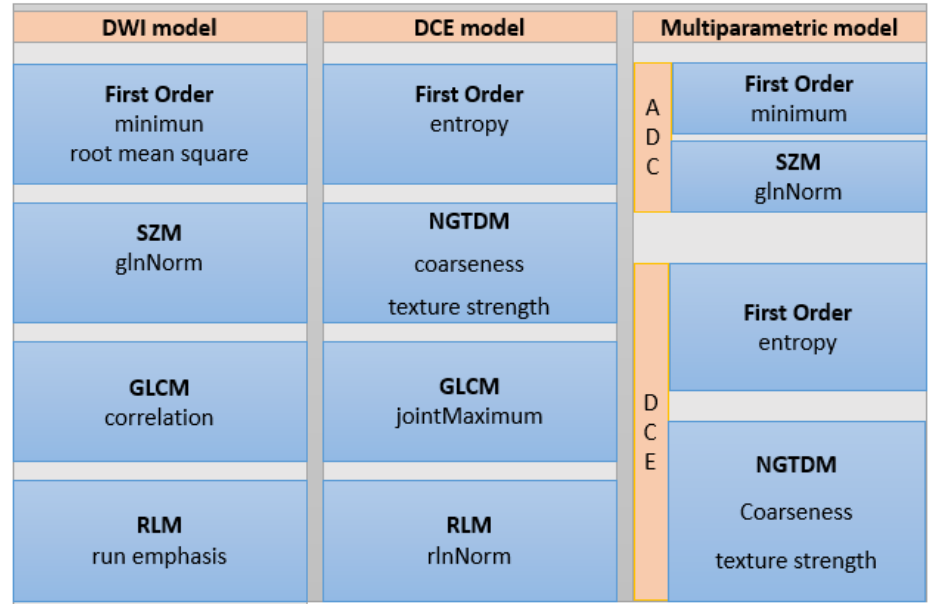
Figure 2. Radiomic features of interest per class and dataset after least absolute shrinkage and selection operator (LASSO) regression. GLCM, gray level co-occurrence matrix; RLM, run length matrix; SZM, size zone matrix; NGDTM, neighborhood gray tone difference matrix; DWI, diffusion- weighted imaging; DCE, dynamic contrast-enhanced; glnNorm, gray level non-uniformity normal- ized; rlnNorm, run length non-uniformity